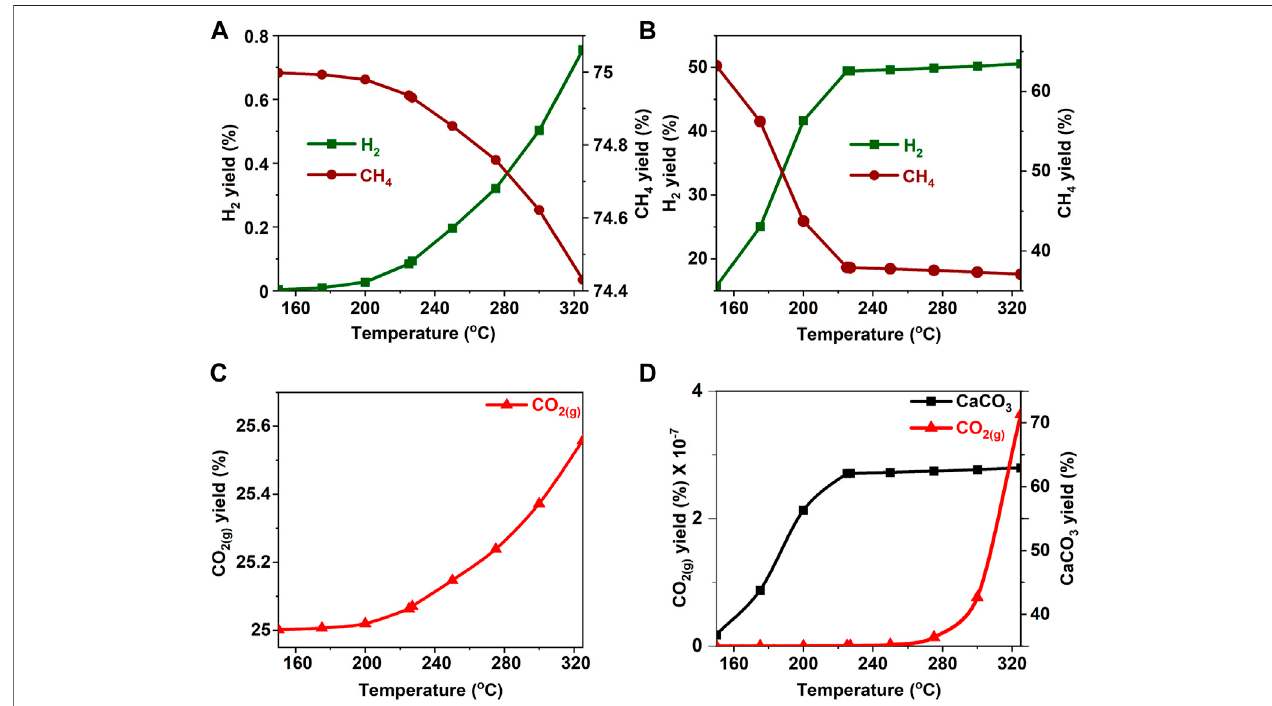
FIGURE9| Effectoftemperatureontheproductyield frommethanol (A , C) in theabsenceand (B) inthepresence ofcalcium oxide.TheyieldofCO 2 post capture to produce calcium carbonate is represented in 7 (D) . These calculations are performed with temperatures of 227 ° C and pressures of 50 bar.